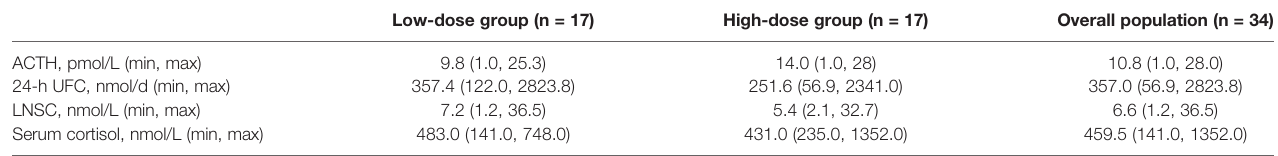
TABLE 2 | Median biochemistry at baseline (ef fi cacy population, n =